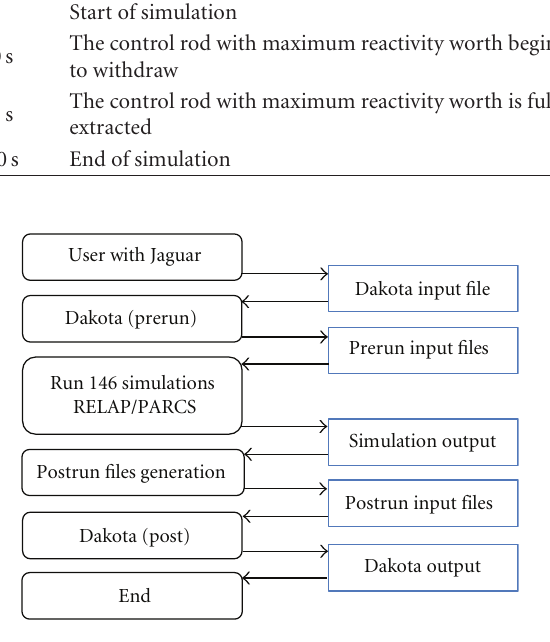
Figure 2: DAKOTA-Jaguar followed methodology.